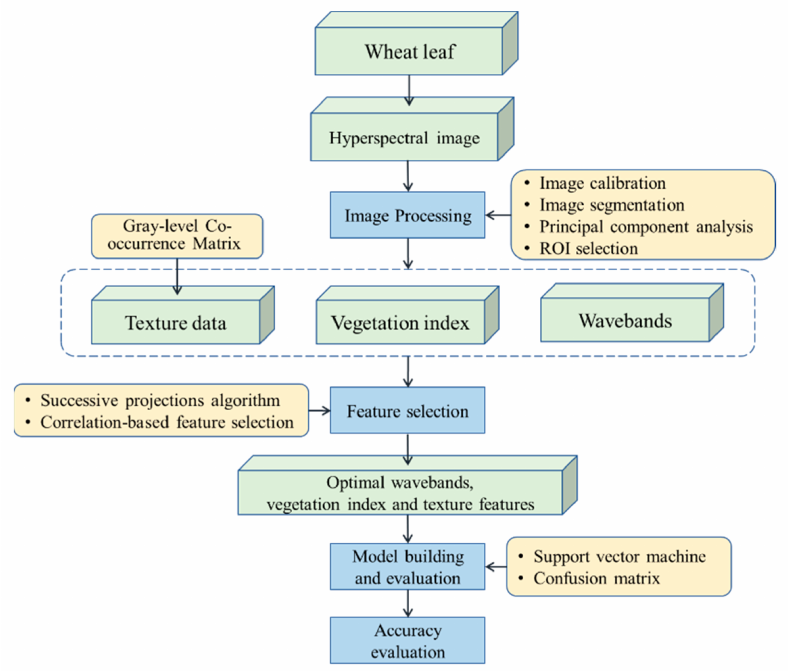
Figure 1. Flow chart for hyper-spectral image data analysis and processing for wheat rust detection [58].